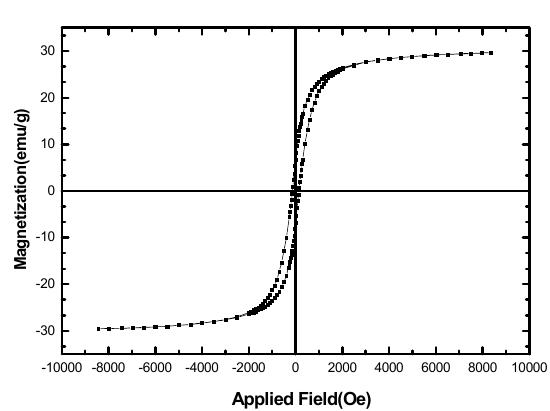
Fig. 6. Room temperature hysteresis loop of magnetic CuFe O nanoparticles 2 4